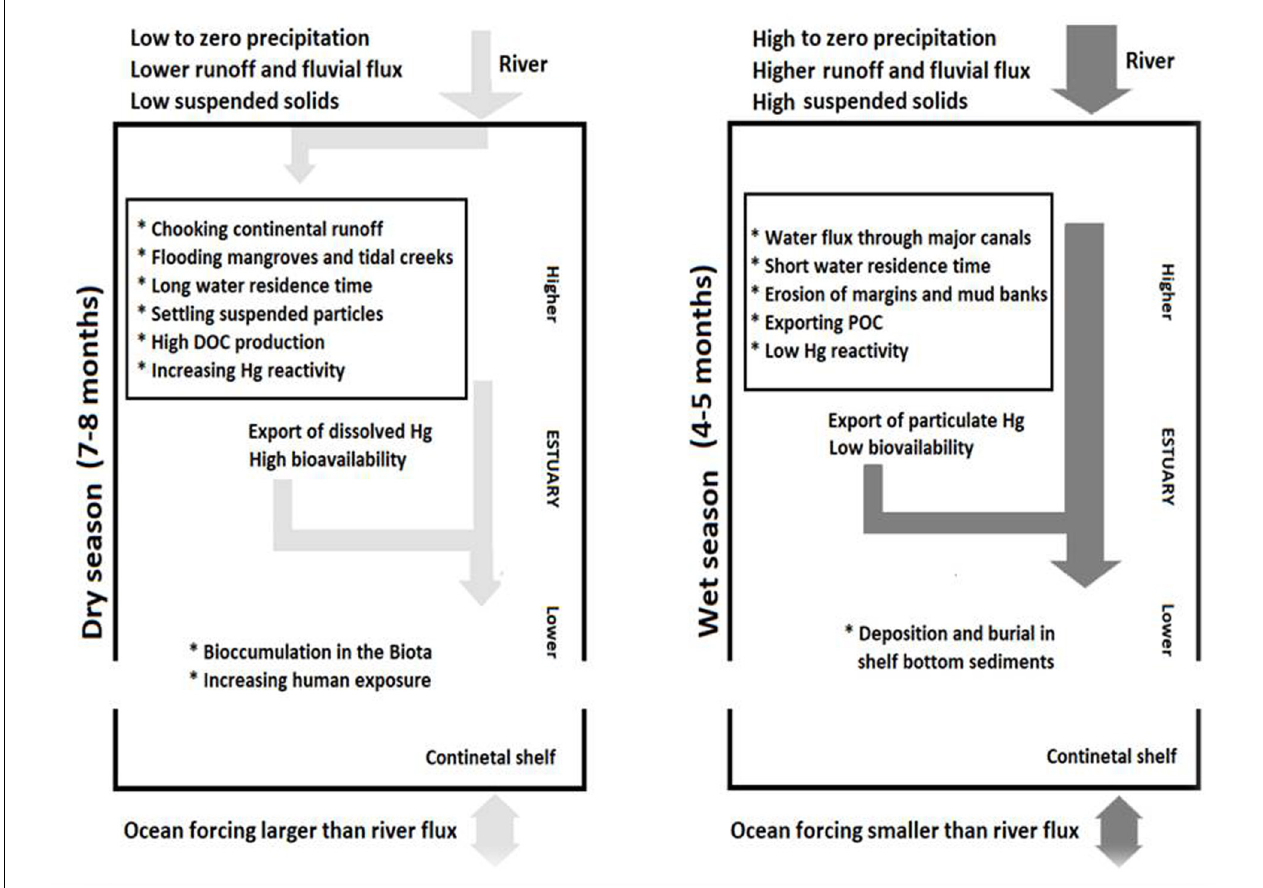
FIGURE 5 | Hydrodynamics and biogeochemical model of the fate of Hg in the Jaguaribe River Estuary, NE